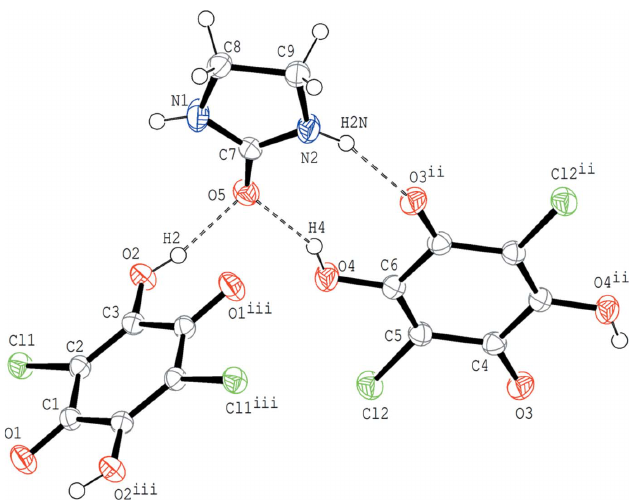
Figure 1 The molecular structure of compound (I), showing the atom-numbering scheme. Displacement ellipsoids of non-H atoms are drawn at the 50% probability level and H atoms are drawn as small spheres of arbitrary radii. O—H (cid:2)(cid:2)(cid:2) O and N—H (cid:2)(cid:2)(cid:2) O hydrogen bonds are shown by dashed lines. [Symmetry codes: (ii) (cid:4) x , (cid:4) y + 1, (cid:4) z + 1; (iii) (cid:4) x + 1, (cid:4) y , (cid:4) z + 1.]